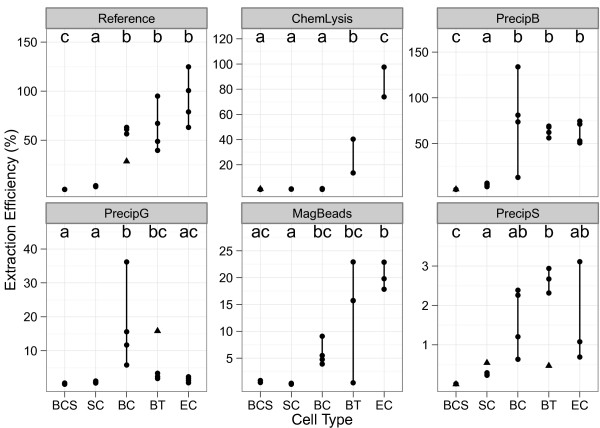
DNA extraction efficiency as a function of cell type quantified by qPCR. Cell types are labeled as follows: B. cereus (spore), BCS, S. cerevisiae, SC, B. cereus, BC, B. thailandensis, BT, E. coli, EC. Vertical lines indicate the dispersion of the data; replicate outliers are indicated as ▲ data points. Black letters (a, b, c) indicate statistical differences within each plot, based on a Tukey’s HSD test with p < 0.05, when the outliers were excluded in the analysis. Plots are grouped by extraction method. Scales are independent for each graph due to the large range in responses